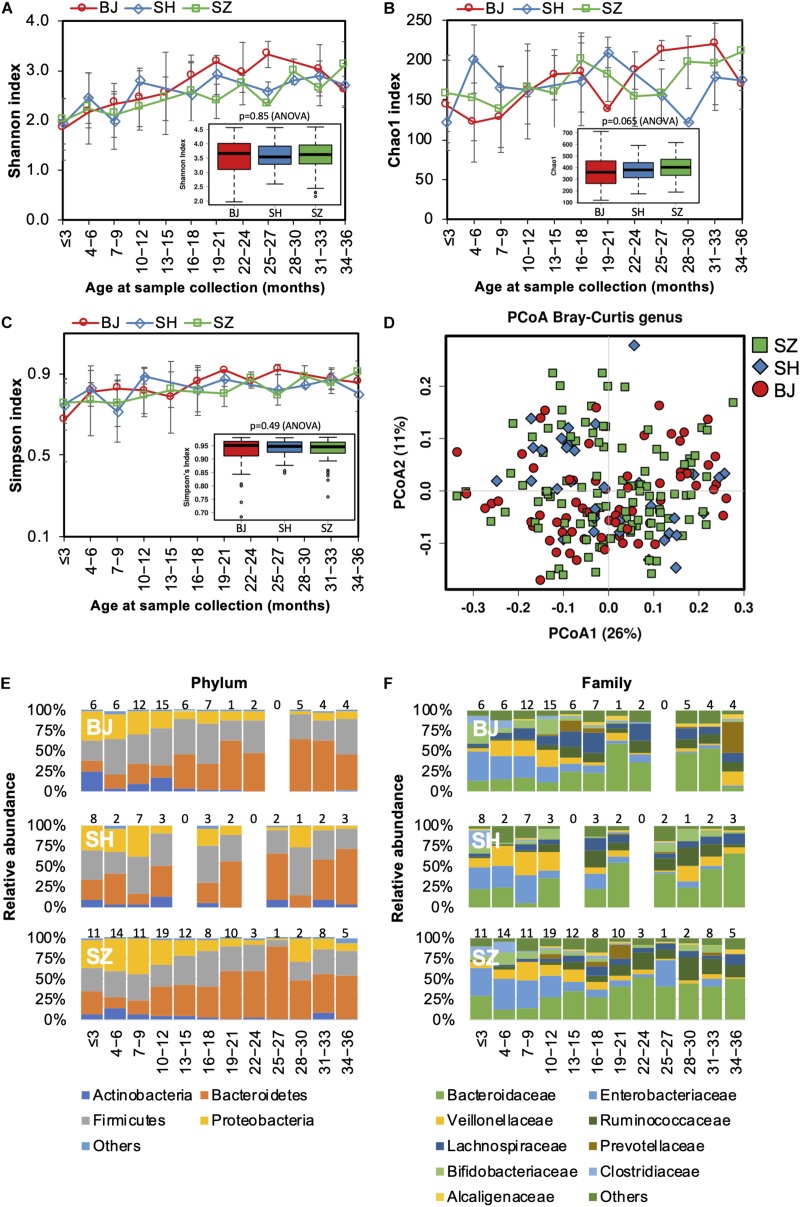
Fecal microbiota diversity and composition for 729 children according to geographical location. Alpha diversity, which was calculated with (A) Shannon index, (B) Chao1, and (C) Simpson’s index, showed no significant difference among the children from three first-tier cities of China. (D) PCoA showed no clear separation among samples of different geographical locations. Gut bacterial microbiota composition at the (E) phylum and (F) family levels. Number of children per age group is provided above bars.